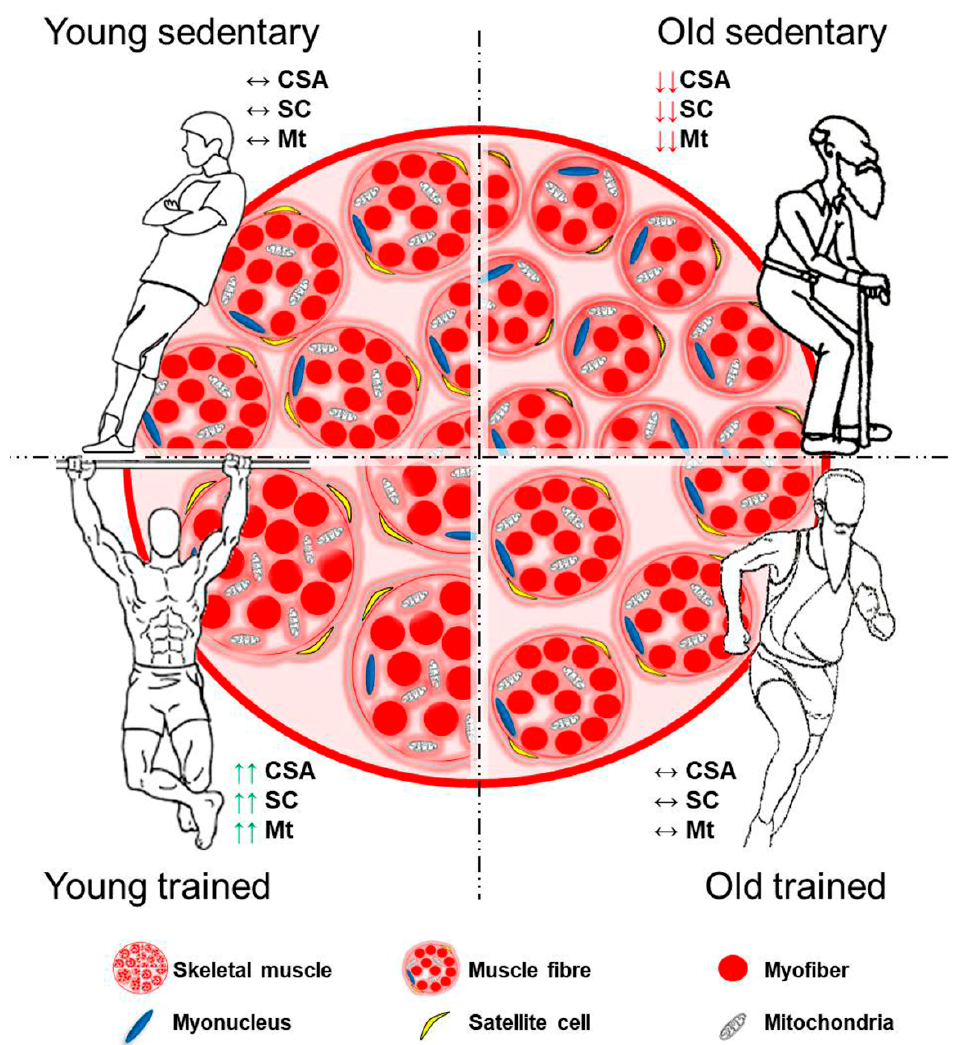
Figure 1. Morphological adaptation induced by physical activity and age on skeletal muscle. Skeletal muscle homeostasis is affected manly by two conditions: physical activity and age. The portrayed skeletal muscle is divided in four sections to represent four different conditions: Young sedentary, old sedentary, old trained, and young trained. Ageing cause muscle fiber atrophy (decrease in cross-sectional area, CSA) to decrease in satellite cells (SC) and mitochondrial (Mt) number. Exercise training can reverse the negative effects of ageing on skeletal muscle. Regular exercise training in young individuals induces specific adaptations, such as an increase in CSA (muscle fiber hypertrophy), SC and Mt number after strength, and/or endurance training.